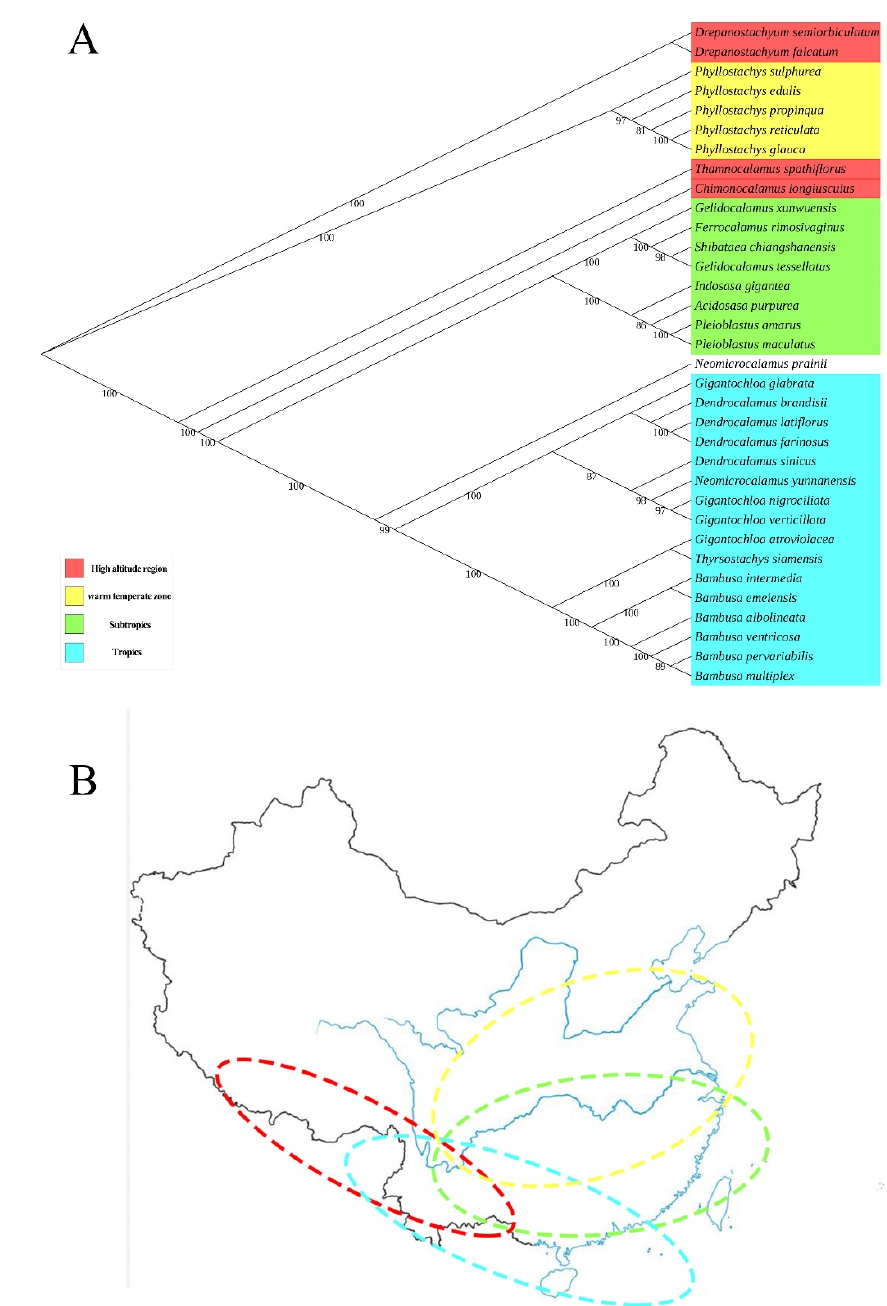
Figure 7. The maximum-likelihood tree based on the 19 cp genomes of Bambuseae and the distribu- tion of the main geographical provenances in China. ( A ) The bootstrap value based on 1000 replicates is shown on each node. ( B ) Distribution of the main geographical provenances of 34 bamboo species in China. Red circle: the distribution of bamboos in high altitude regions; Yellow circle: the distri- bution of bamboos in the warm temperate zone; Green circle: the distribution of bamboos in the subtropics; Blue circle: the distribution of bamboos in the